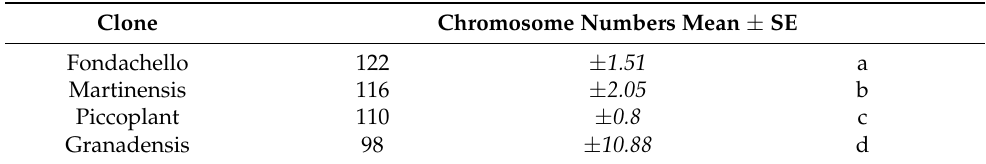
Table 1. Chromosome numbers in each clone. Values represent the mean ± SE of fifty replicates ( n = 50). Values with different letters are significantly different ( p < 0.05) according to the Tukey test. Clone Chromosome Numbers Mean ± SE Fondachello 122 ± 1.51 a Martinensis 116 ± 2.05 b Piccoplant 110 ± 0.8 c Granadensis 98 ± 10.88